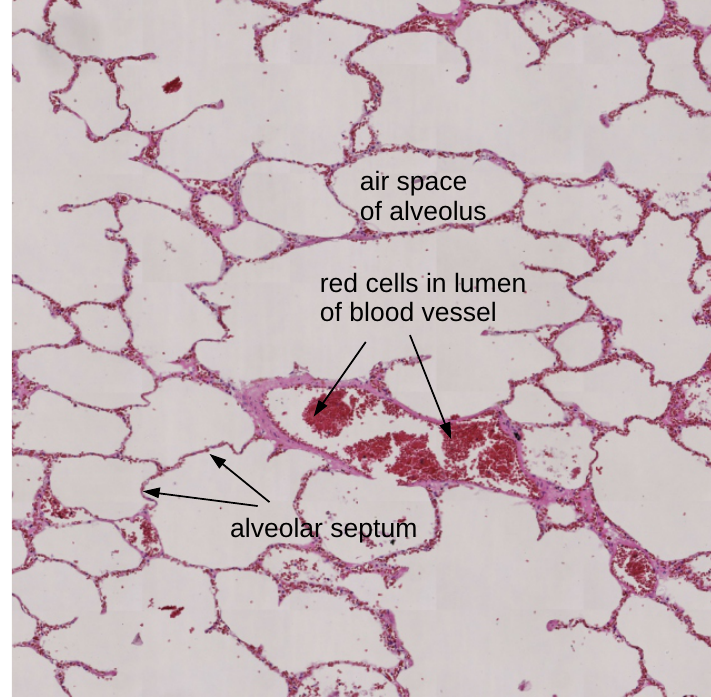
Figure 1. Example of lung